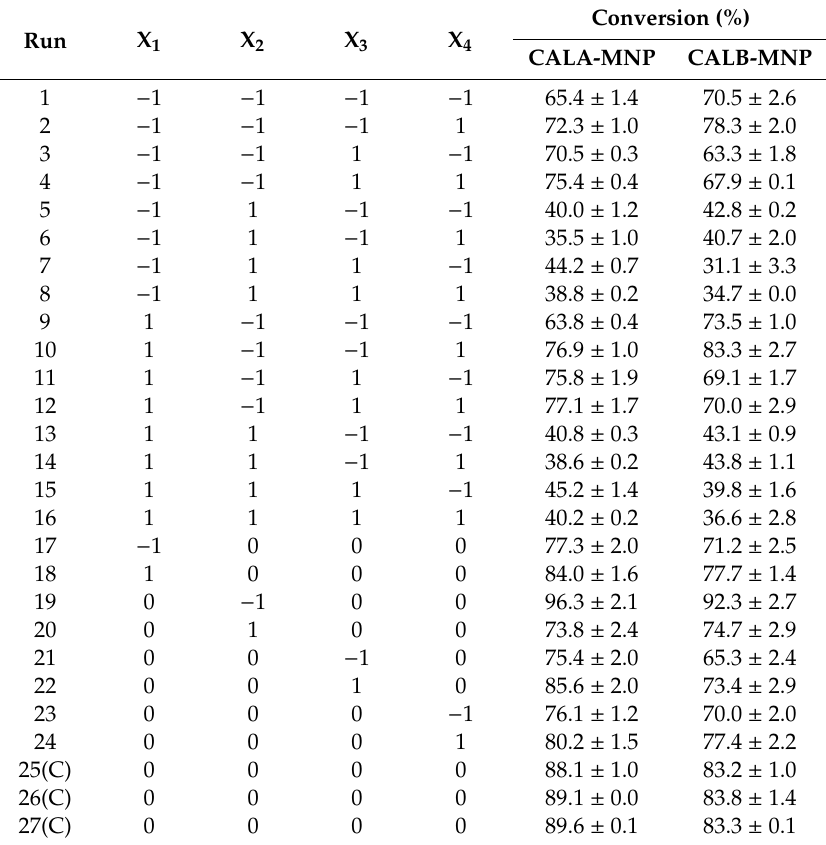
Table 2. Coded values and results for the CCD. Further details are given in Section